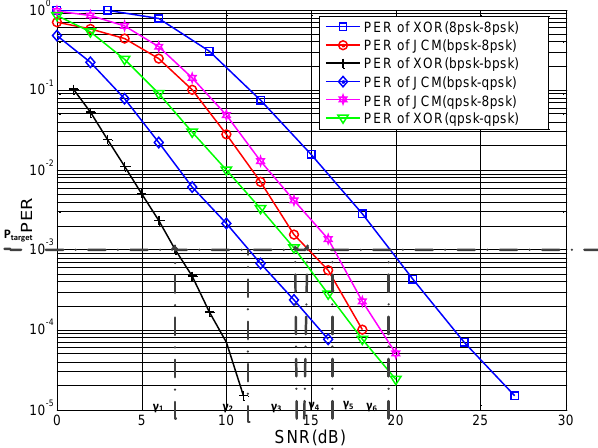
Fig.5 PER performance and SNR regions for six transmission modes with The spectral efficiency of a TWR network with multiple antennas with our proposed cross-layer design is shown in Fig.6, with different numbers of retransmission of . It is shown that the system spectral efficiency increases with the increasing of retransmission times. However, the improvement of spectral efficiency decreases as the number of retransmission increases. As increases, the target PER at the physical